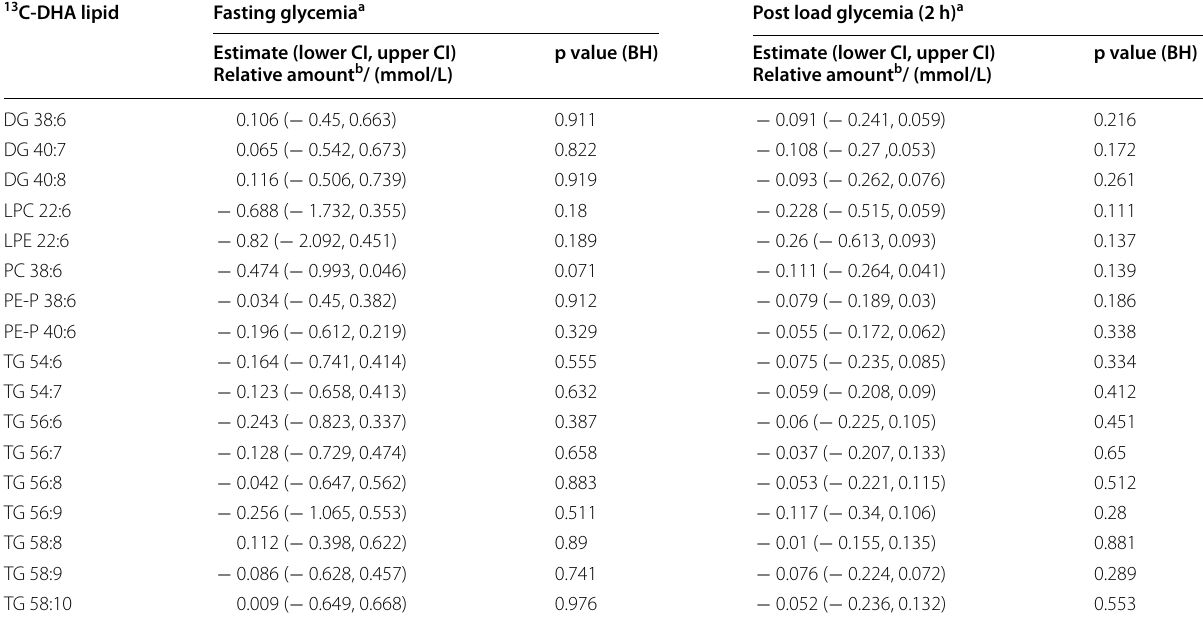
Table 2 Associations between maternal glycemia and change in 13 C‑DHA lipids with in‑vitro glucose treatment (glucose response) in placental explants (n =